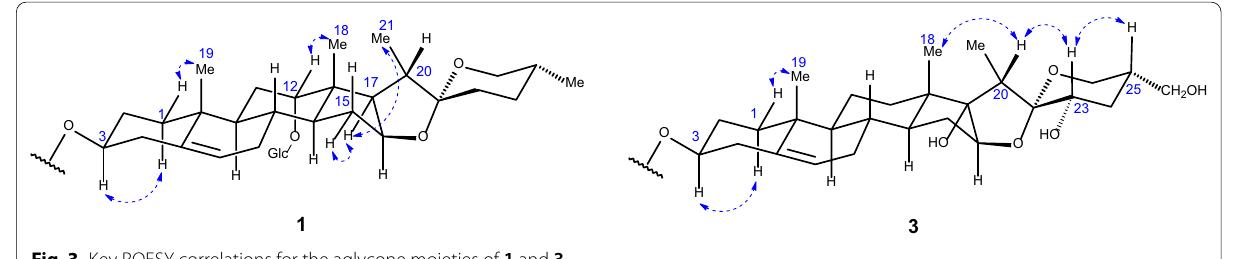
Fig. 3 Key ROESY correlations for the aglycone moieties of 1 and